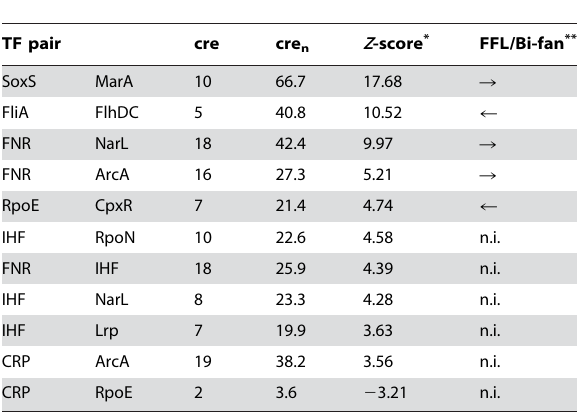
Table 1. Pairs of hubs exhibiting significant coregulation.